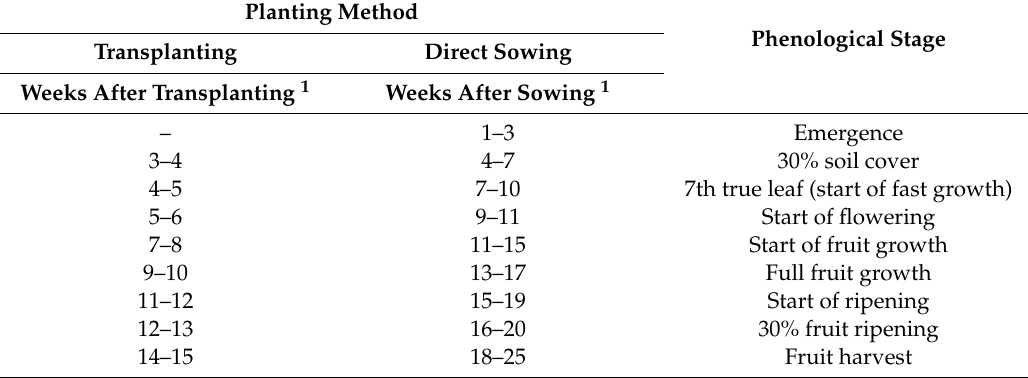
Table 1. Phenological stages for a processing tomato crop grown in Northern Italy (Gianquinto, personal